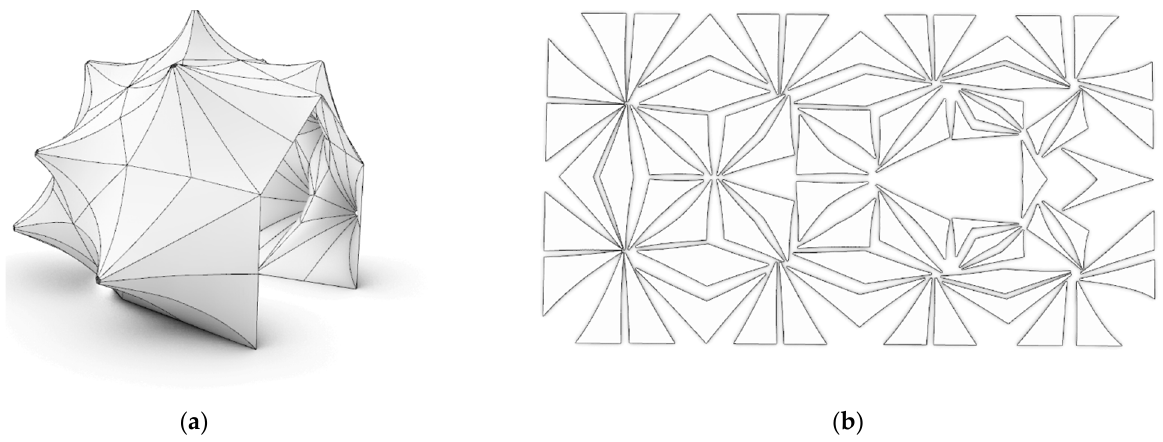
Figure 12. ( a ) the 3D model with simplified, ruled patches; ( b ) patches in a flat configuration, prepared for fabrication.